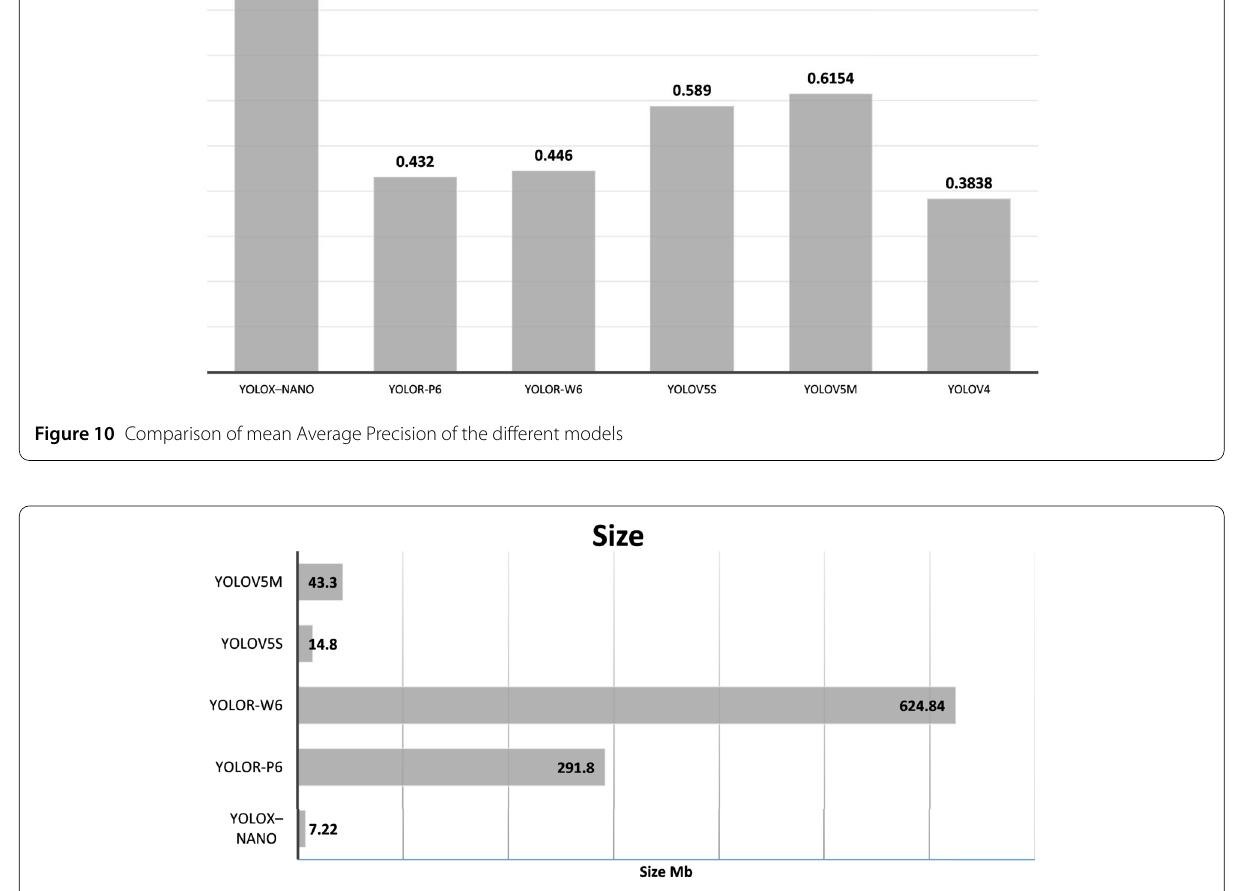
Figure 11 Comparison of size of the trained model. YOLOX-nano has the lowest